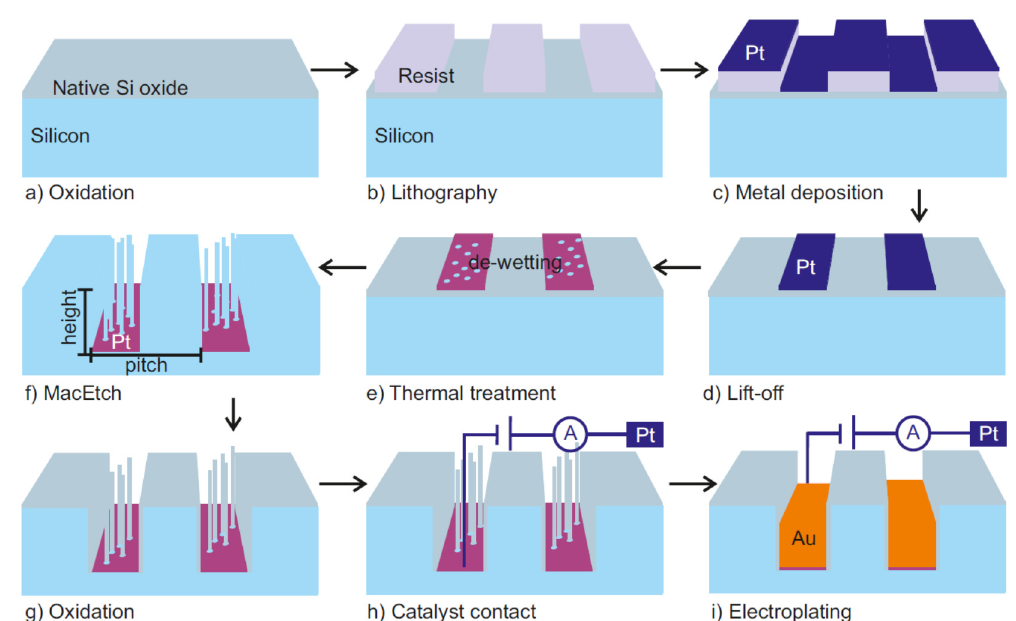
Figure 12. Schematic illustration of the grating fabrication process by MacEtch and subsequent Au electroplating: ( a ) growth of native silicon oxide on Si substrate, ( b ) pattern definition by means of a lithographic process, ( c ) Pt deposition by evaporation, ( d ) lift-off, ( e ) Pt de-wetting by thermal treatment, ( f ) MacEtch in a solution of HF and H 2 O 2 , ( g ) Si side wall oxidation in air, ( h ) electrical contact of the catalyst metal interconnected pattern to the electroplating electrode, ( i ) seeded Au growth by electroplating. The Pt pattern works as a catalyst for MacEtch and as a seed layer for Au electroplating. The figure was adapted with permission from L. Romano et al, 2020. [21].